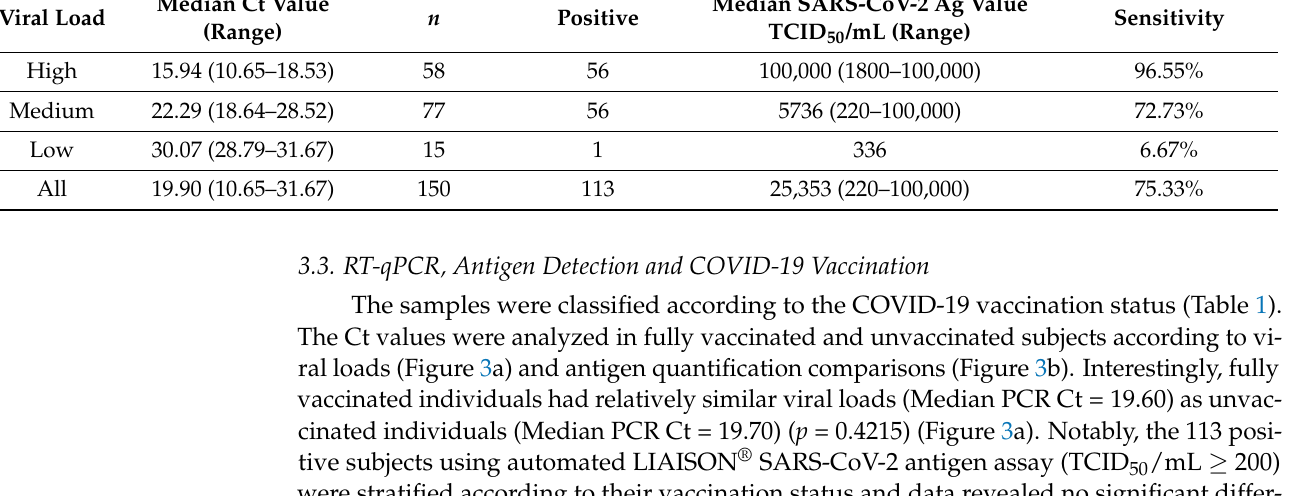
Figure 2. Linear regression of RT-qPCR Ct values versus the level of antigen (log10 transformed TCID50/mL results) obtained on the DiaSorin LIAISON SARS-CoV-2 Ag assay.